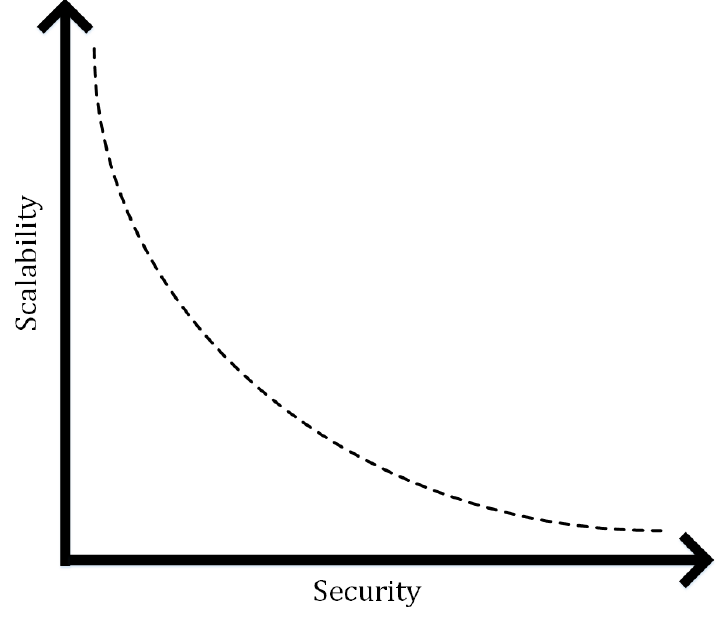
Figure 7. Security vs. scalability in blockchain based frameworks.